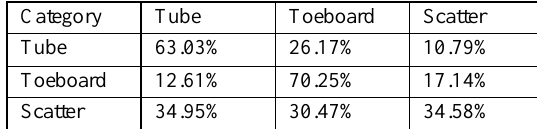
Table 3. Confusion matrix of real point cloud